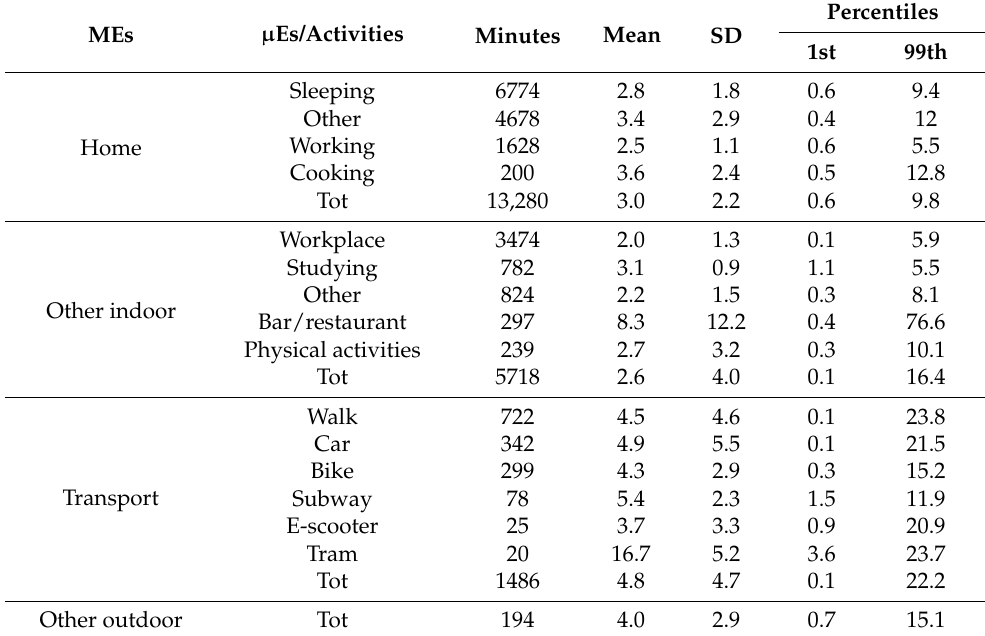
Table 2. Statistics of the measured eBC ( µ g/m 3 ) according to the different macro- and micro- environments/activities. MEs µ